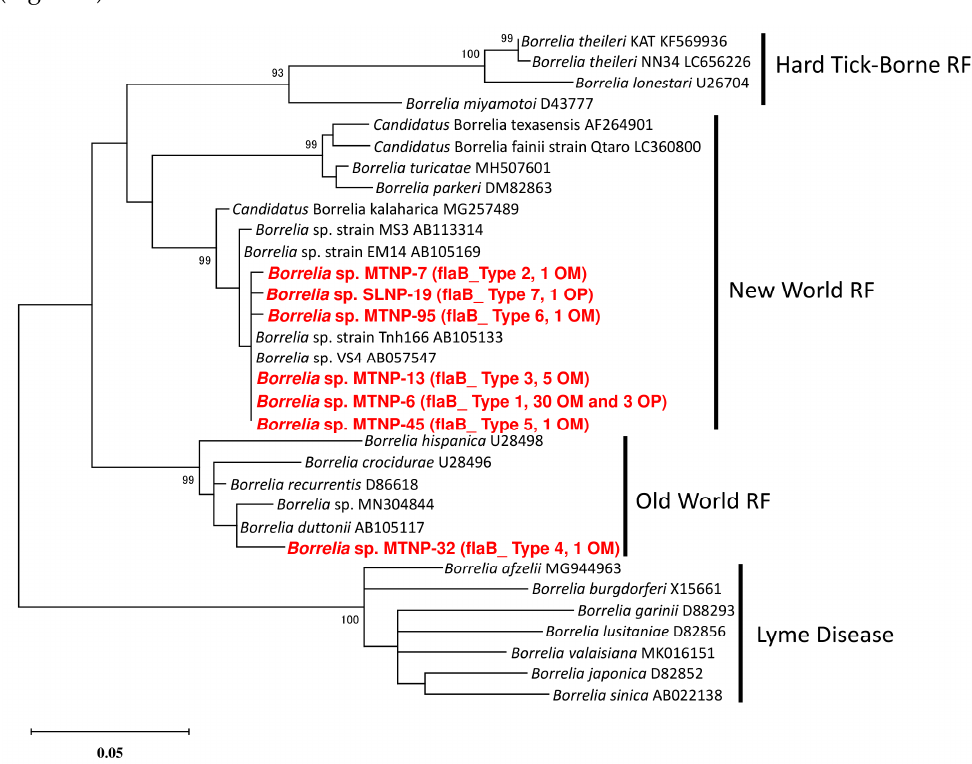
Figure 2. Phylogenetic tree of the Borrelia spp. based on the partial sequence of the flagellin gene flaB . Analyses were performed by the maximum likelihood (ML) method with the Kimura-2 parameter. The sequences generated herein are displayed in bold and red font. The flagellin sequence variations and the numbers of the samples with the same sequence are enclosed in brackets. OM and OP refer to Ornithodoros moubata and O. porcinus , respectively. Bootstrap values > 70% are based on 1000 replications and are shown beside the branches.